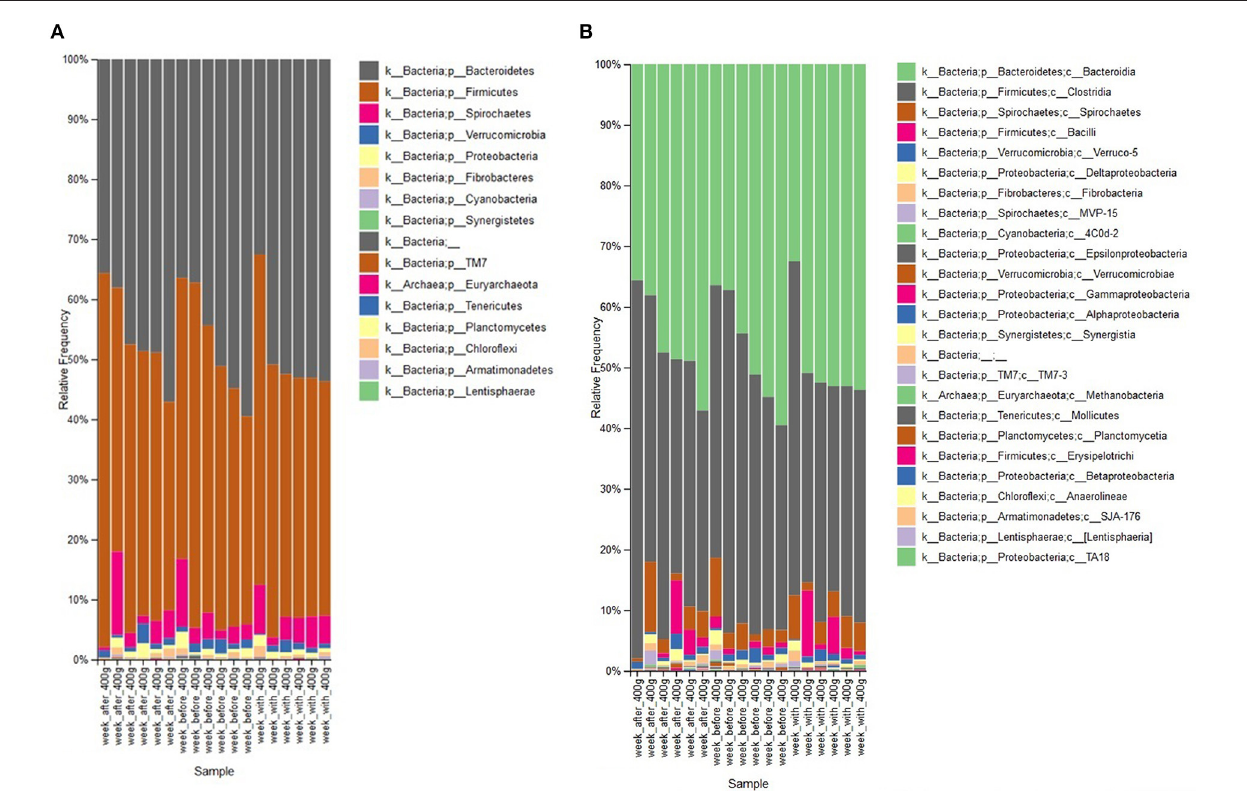
FIGURE 4 | (A) Comparison of relative abundance of bacterial phyla present in feces of the horses that were supplemented with aleurone 400 g/day for 1 week with the relative abundance 1 week before the 400 g/day supplementation and 1 week after the 400 g/day supplementation. (B) Comparison of relative abundance of bacterial classes present in feces of the horses that were supplemented with aleurone 400 g/day for 1 week with the relative abundance 1 week before the 400 g/day supplementation and 1 week after the 400 g/day